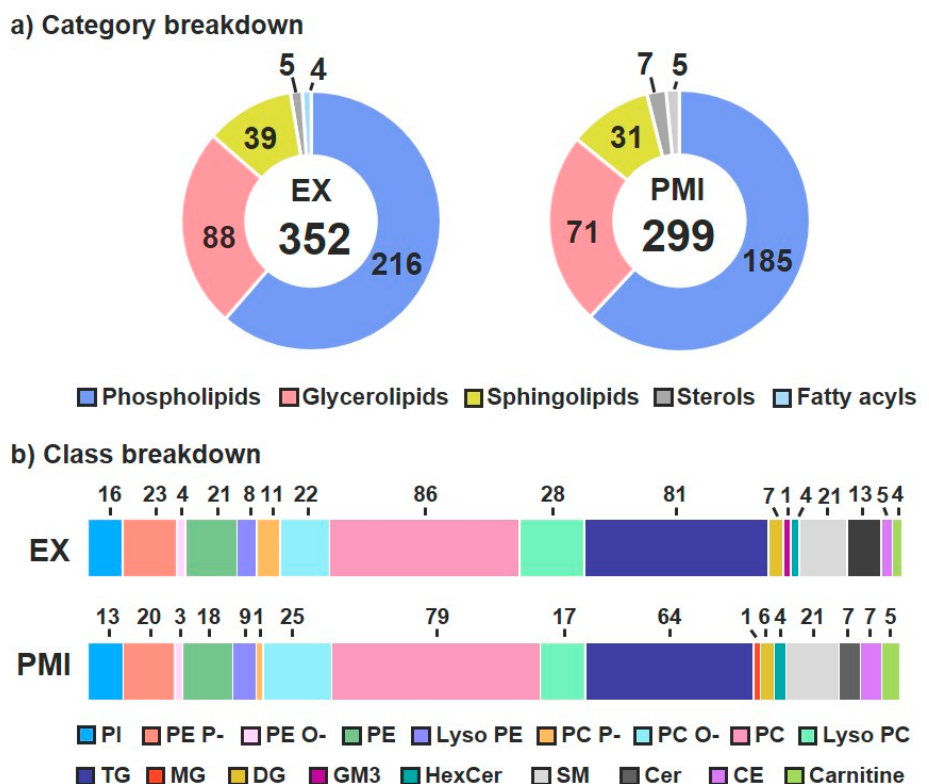
Figure 2. Identified lipid category and class coverage. ( a ) Five lipid categories were observed for plasma from patients in both the ETT ( left ) and PMI ( right ) cohorts. ( b ) In the class breakdown, the majority of the lipids fall within the sphingolipid, glycerolipid and phospholipid categories.